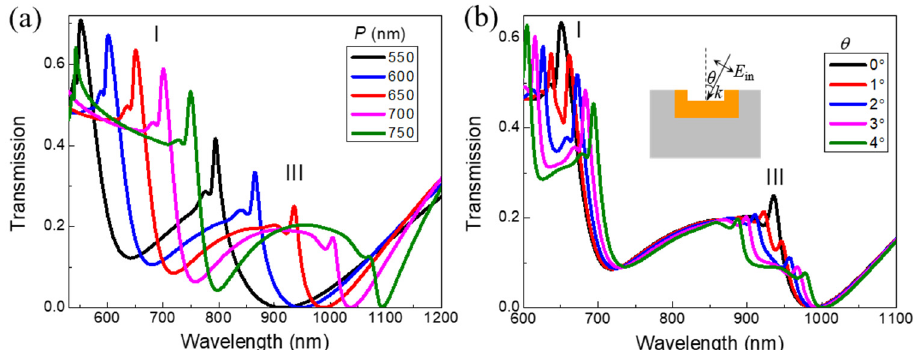
Figure 3. ( a ) The calculated transmission spectra of the Au VSRR embedded in the silica substrate for different period ( P ) under normal incidence of light for TM polarization, where the other geometric parameters are the same as shown in Figure 2a. ( b ) The calculated transmission spectra of the Au VSRR embedded in the silica substrate for various incident angles ( θ ) with TM polarization, where all the geometric parameters are the same as shown in Figure 2a.